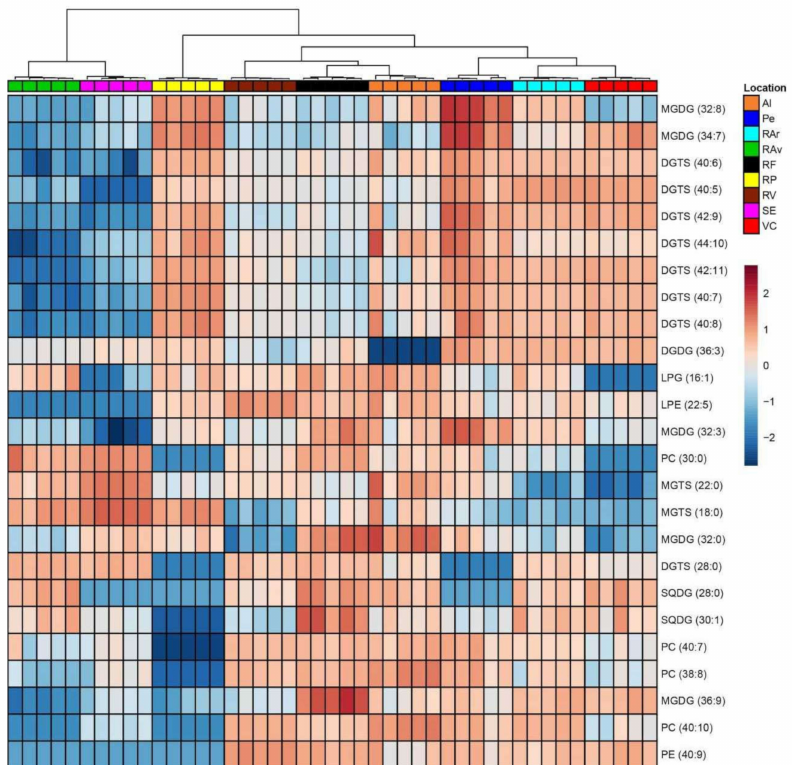
Figure 2. Hierarchical clustering heatmap of lipid species data. Levels of normalized peak area are shown on the color scale, with numbers indicating the fold di ff erence from the mean. The clustering of the sample groups is represented by the dendrogram of the top 25 lipid species displaying the lowest Tukey’s HSD test q-values. Labels of the sites are according to the notation: Albufeira (Al), Peniche (Pe), Ria Arousa (RAr), Ria de Aveiro (RAv), Ria Formosa (RF), Ria de Pontevedra (RP), Ria de Vigo (RV), Sado Estuary (SE), and Viana do Castelo (VC). Labels of lipid species are according to the notation: AAAA (C:N), (AAAA, lipid class; C, total carbon atoms; N, total double bonds of fatty acid